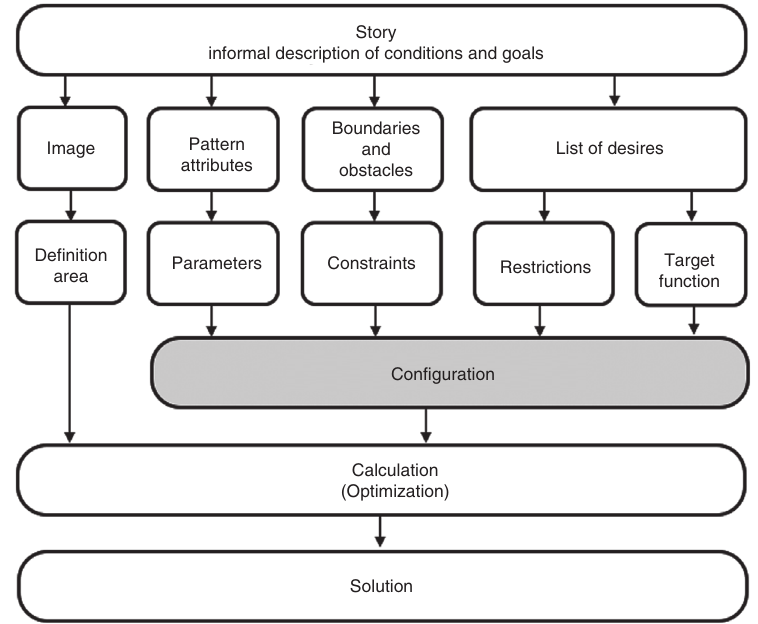
Figure 7. Pattern-Matching